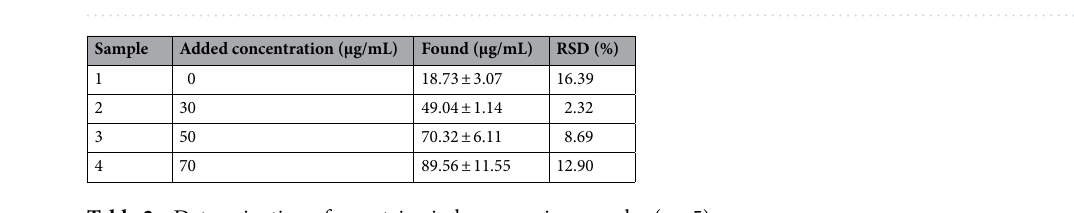
Table 2. Determination of l-cysteine in human urine samples (n = 5).